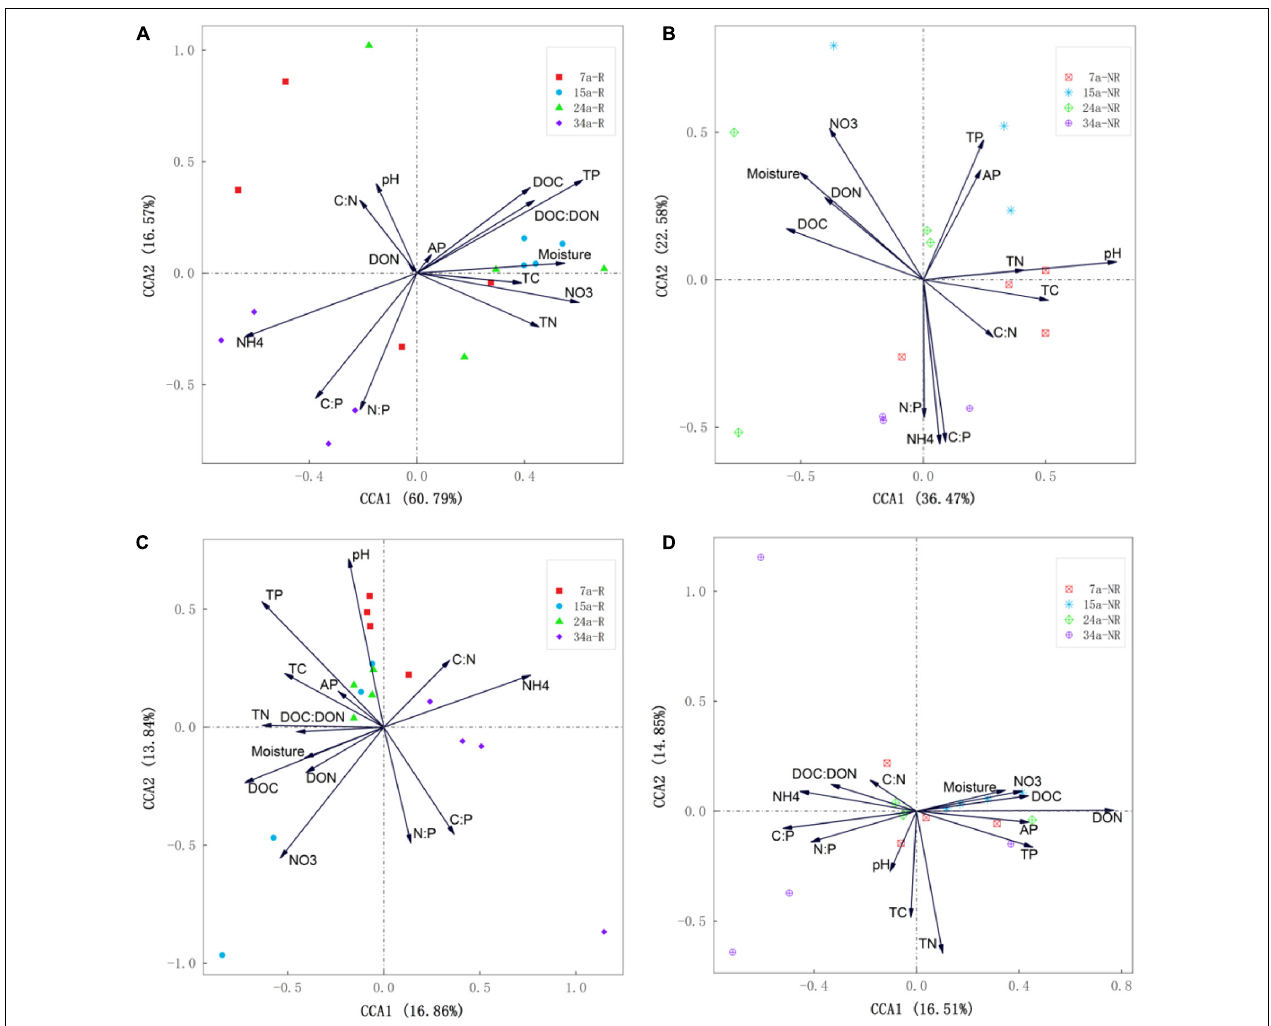
FIGURE 5 | Canonical correspondence analysis (CCA) illustrating the effects of environmental factors (arrows) on rhizosphere soil bacterial (A) and fungal (C) community structure (symbols) among different stand ages. CCA illustrating the effects of environmental factors (arrows) on bulk soil bacterial (B) and fungal (D) community structure (symbols) among different stand ages. The values of axes 1 and 2 are the percentage that can be explained by the corresponding